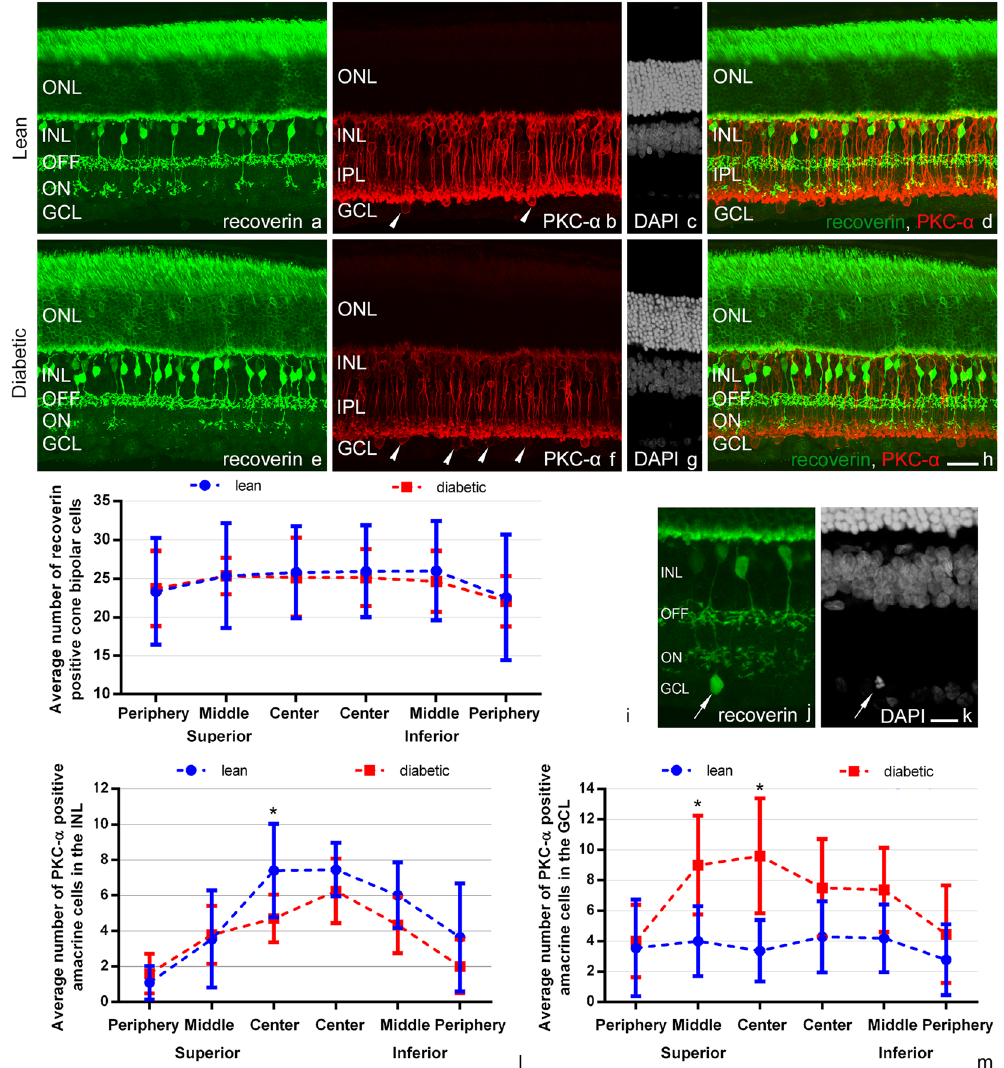
Figure 6. Cone and rod bipolar cells in diabetes. Cone and rod bipolar cells were analysed using anti-recoverin ( a , e , j in green) and anti-PKC- α ( b , f in red) antibodies, respectively. For orientation cell nuclei were labelled with DAPI-staining ( c , g , k ). Merged view: d , h . Both bipolar cell types including ON and OFF cone bipolar subtypes showed normal morphology in diabetes (second row) compared to controls (upper row). PKC- α also labelled at least one population of amacrine and displaced amacrine cells (arrowheads in b and f ), while recoverin also stained all photoreceptor cells and a low number of cells in the ganglion cell layer with cone or rod like nuclear morphology (arrows in j and k ). Quantitative analysis showed no evident change in the number of recoverin positive cells in any region of the retina ( i ). There was an increase in the number of PKC- α positive, displaced amacrine cells in the GCL in the superior central and mid-peripheral retinal regions ( m ). In contrast the number of PKC- α positive amacrine cells in the INL decreased or showed no change in diabetes ( l ). Significant differences (p < 0.05) were labelled with * . ONL: outer nuclear layer, INL: inner nuclear layer, IPL: inner plexiform layer, ON and OFF: sublayers of the IPL, GCL: ganglion cell layer. Bar : 20 μ m ( a – h ) and 10 μ m for j and k